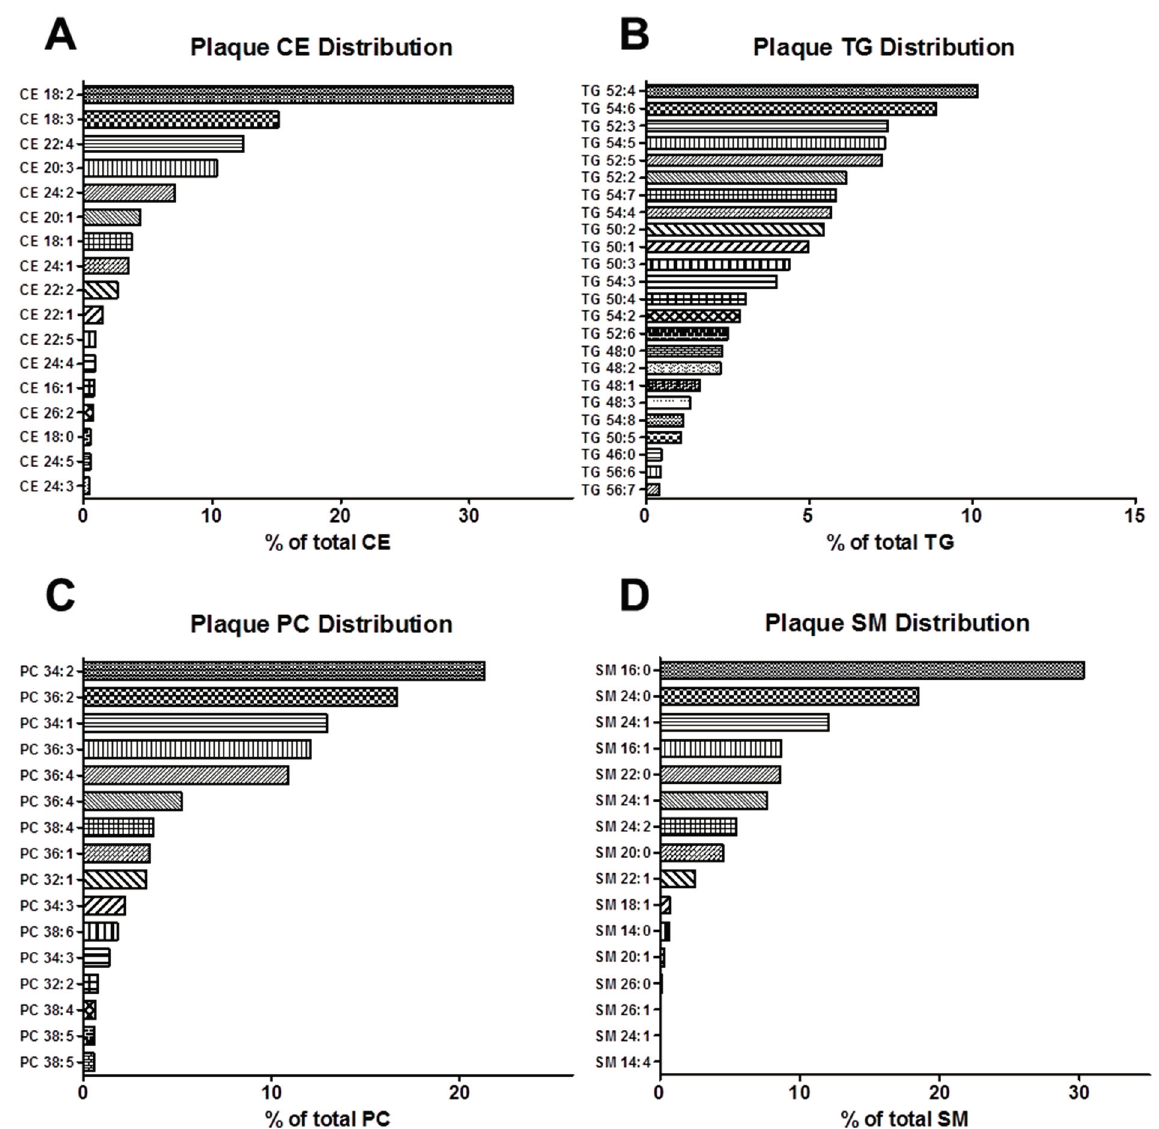
Figure 2. Fatty acyl composition of plaque lipids: Targeted analysis of lipids was conducted on full-length aortae isolated from rabbits fed the HC diet by UPLC/TOF-MS. ( A ) Plaque cholesteryl esters (CE); ( B ) Plaque triacylglycerols (TGs); ( C ) Plaque phosphatidylcholines (PCs); and ( D ) Plaque sphingomyelins (SMs). All data is presented as the percent of the given lipid species of the total lipid class.